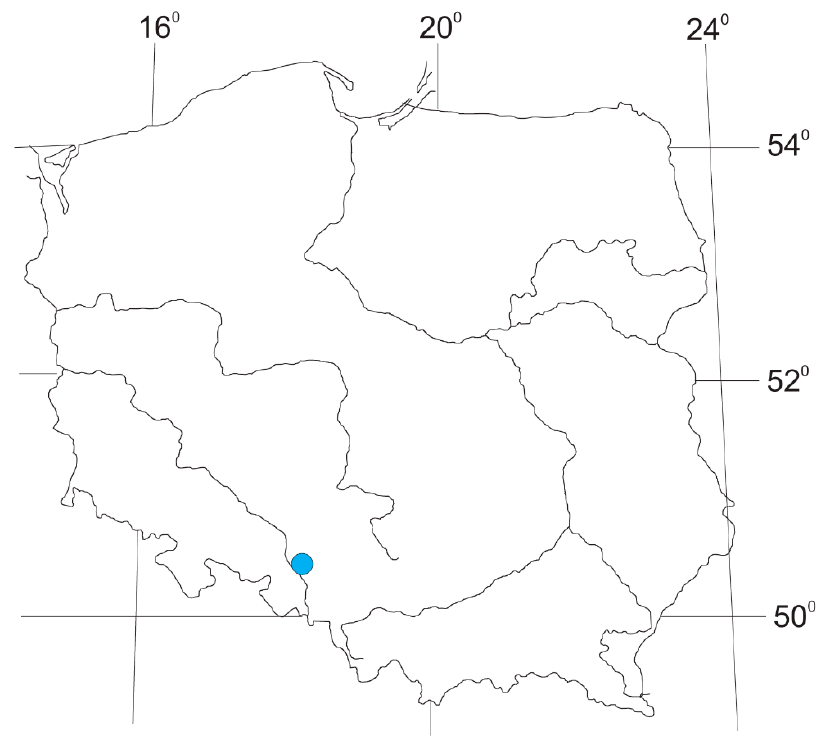
Figure 1. Locality of Potametum alpini Podbielkowski 1967 in the limnocrene karst spring in Poland.